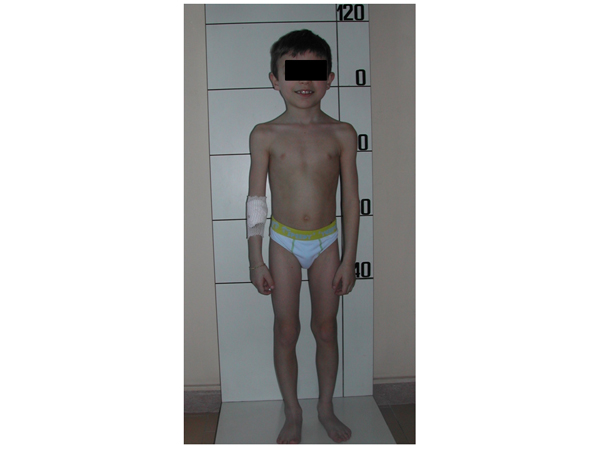
Patient's phenotype.